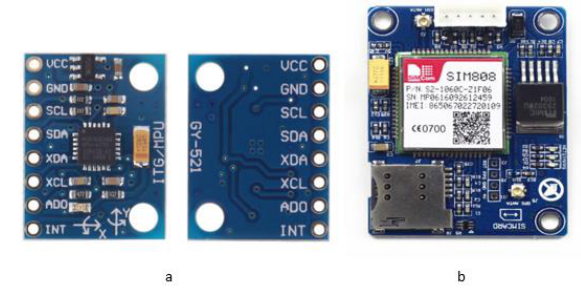
Figure 3. The main components of the designed system